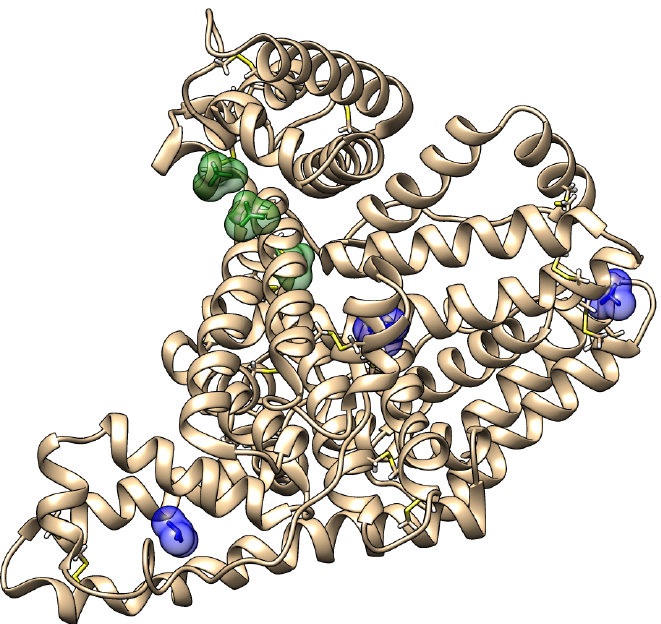
Figure 1. HAS in complex with TMA (blue coloured) and TMAO (green coloured) in their respective lowest energy binding poses; the ligands are reported in a stick model with a VdW transparent surface.